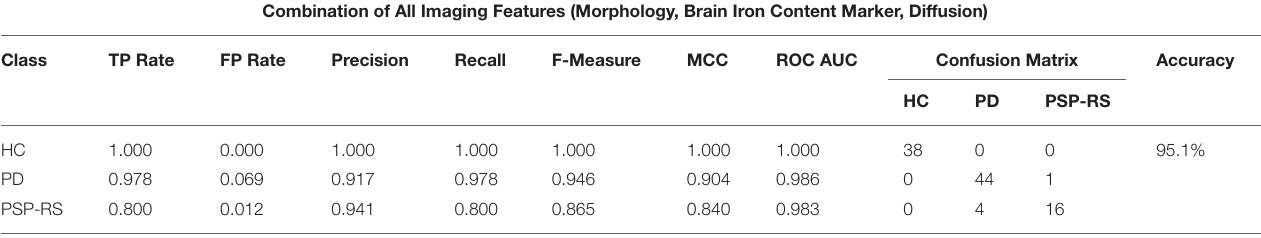
TABLE 6 | Confusion matrix following an SVM based feature selection + MLP classification combination using features from multiple MRI modalities. Combination of All Imaging Features (Morphology, Brain Iron Content Marker, Diffusion)